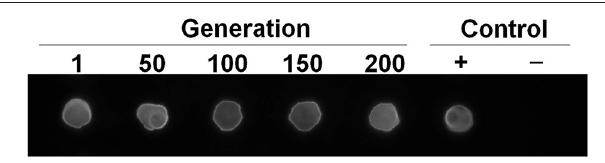
FIGURE 4 | Assessment of Vi-production in various generations of SPA-VPH. Tested bacteria were suspended in PBS, and lysed by addition of equal volume of 10% SDS. Bacterial lysates were added onto a nitrocellulose membrane. The Vi polysaccharide binding to the membrane was detected with spot immunoblotting and visualized with enhanced chemiluminescence detection kit. Rabbit anti-Vi serum was used as the primary antibody. A goat anti-rabbit immunoglobulin G conjugated with horseradish peroxidase was used as the secondary antibody. Positive control is Vi-encapsulated Salmonella enterica serovar Typhi Ty2. Negative control is Salmonella enterica serovar Paratyphi A